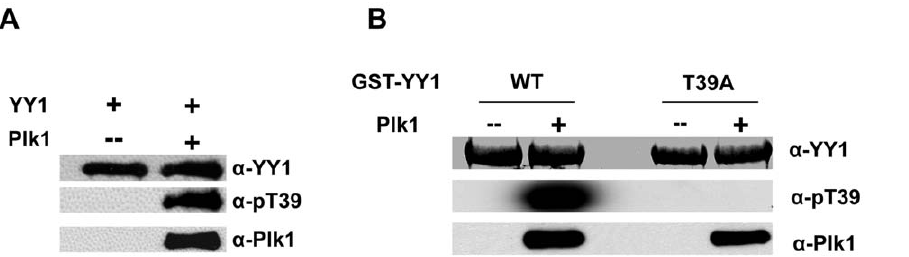
Figure 4. Anti-p-T39 antibody specifically recognizes YY1 phosphorylation at threonine 39. ( A ) Western blot analysis of the cold in vitro kinase assay reactions using purified Plk1 and purified YY1, after SDS-PAGE. The blot was probed with anti-YY1, anti-Plk1 and anti-pT39 antibodies. ( B ) Western blot analysis of the cold in vitro kinase assay reactions after SDS-PAGE, using purified Plk1 and purified GST-YY1 wild type (WT) or mutant (T39A). The blot was probed with anti-YY1, anti-Plk1 and anti-pT39